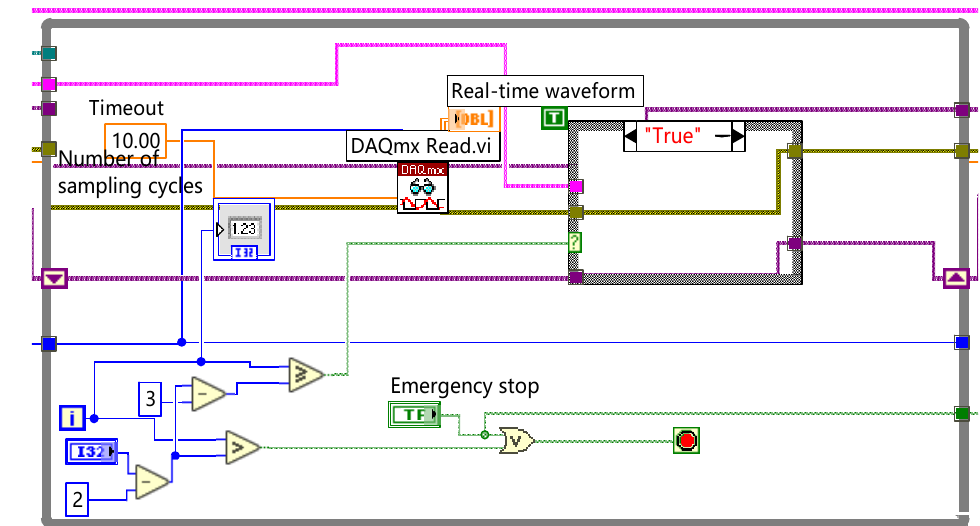
Figure 8. Program diagram of the